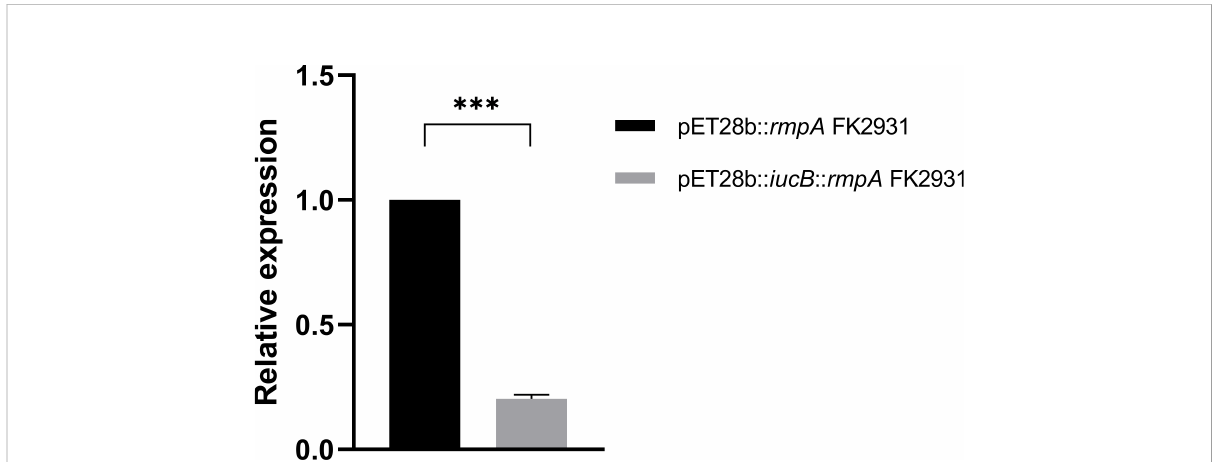
FIGURE 3 Effect of iucB gene on the expression of rmpA gene. *** indicates a statistical